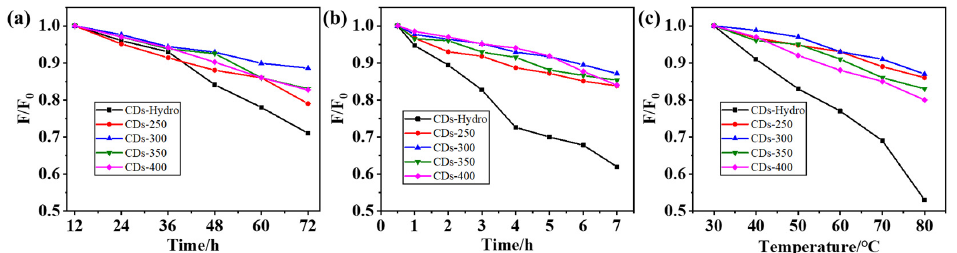
Figure 8. Decay curve of PL intensity of CDs-Hydro, CDs-250-400 with increasing ( a ) visible and ( b ) UV irradiation time. ( c ) Decay curve of PL intensity of CDs-Hydro, CDs-250-400 with increasing temperature.